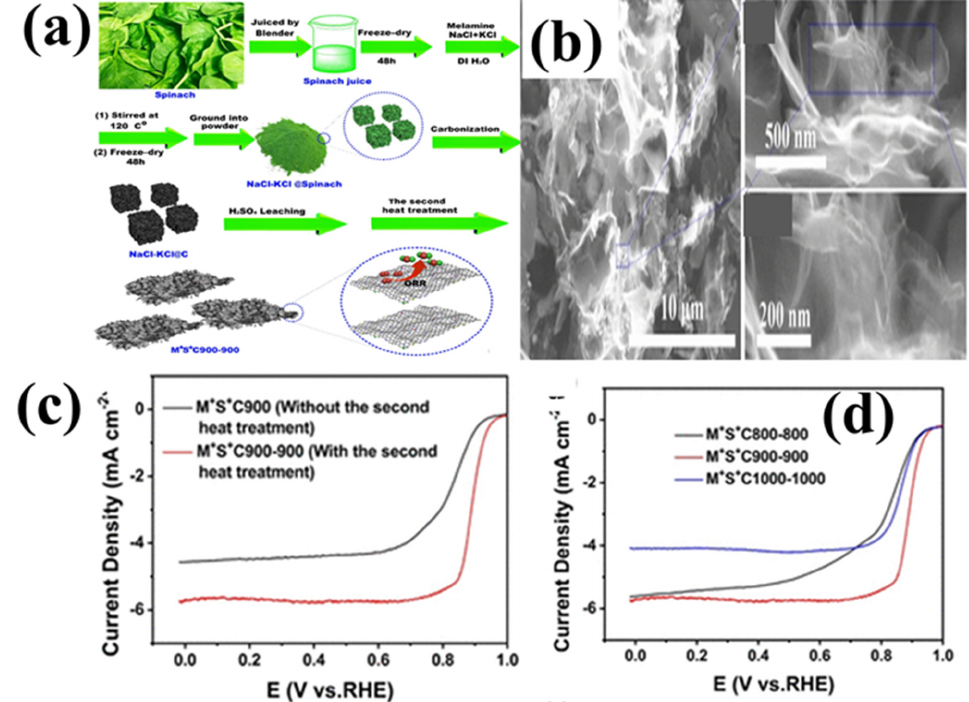
Figure 12. ( a ) Schematic of the procedure for preparing spinach-derived carbon nanosheets, ( b ) SEM images of M + S + C900–900, ( c ) effects of second heat treatment at 900 ◦ C ( d ) effects of different reagents on the starting materials. (The LSV curves were recorded in O 2 -saturated 0.1 M KOH with a rotation speed of 1600 rpm and a potential scan rate of 10 mV s − 1 ), adapted from [80].